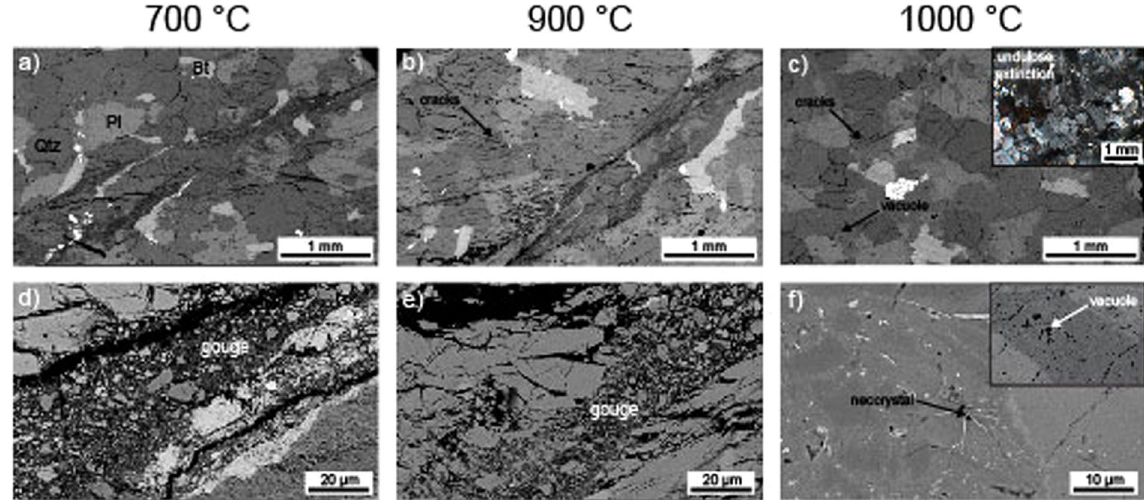
Figure 4. Backscattered scanning electron photomicrographs (SEM) of the samples of Westerly granite (thermally-shocked to 450 °C) deformed at an effective confining pressure of 100 MPa and an axial strain rate of 10 − 5 s − 1 (the deformation experiments shown in Fig. 2). ( a ) and ( d ) are SEM images of the sample deformed at 700 °C, showing a shear band containing fine-grained gouge. Qtz – quartz; Pl – plagioclase; Bt – biotite. ( b ) and ( e ) are SEM images of the sample deformed at 900 °C, showing a shear band containing fine-grained gouge. ( c ) and ( f ) are SEM images of the sample deformed at 1000 °C, for which no strain localisation was found. Inset in panel (c) is an optical microscopic image showing undulose extinction in crystals of quartz. Panel (f) shows a neocrystal; the inset shows vacuoles within a feldspar